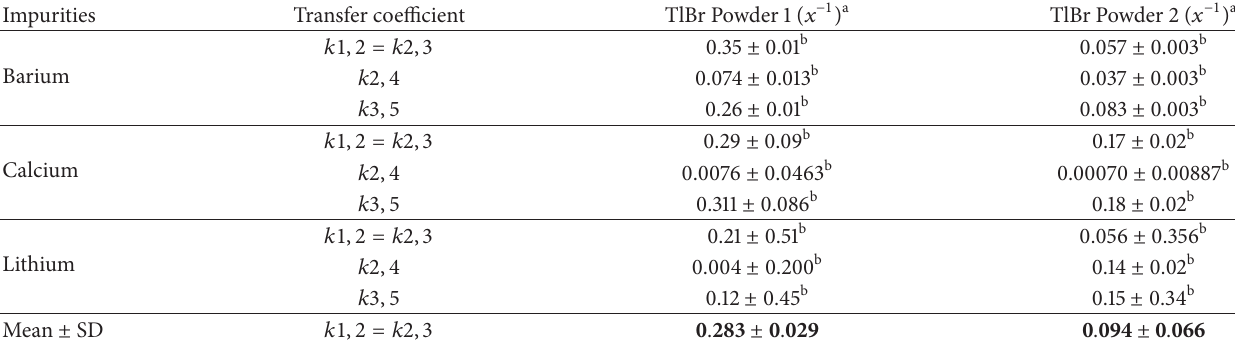
Table 2: Impurity migration coefficients.